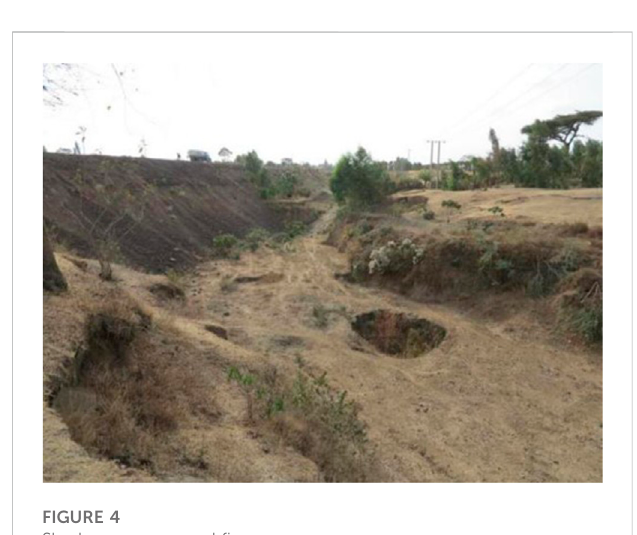
FIGURE 4 Shashemene exposed fi